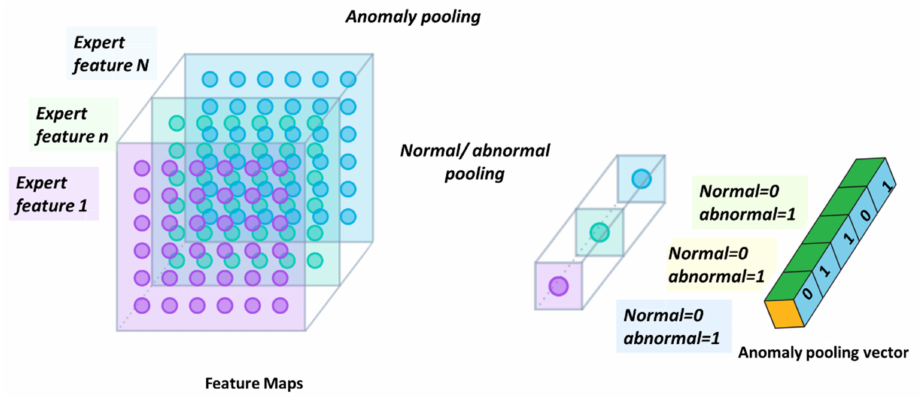
Figure 8. Demonstration of the pooling